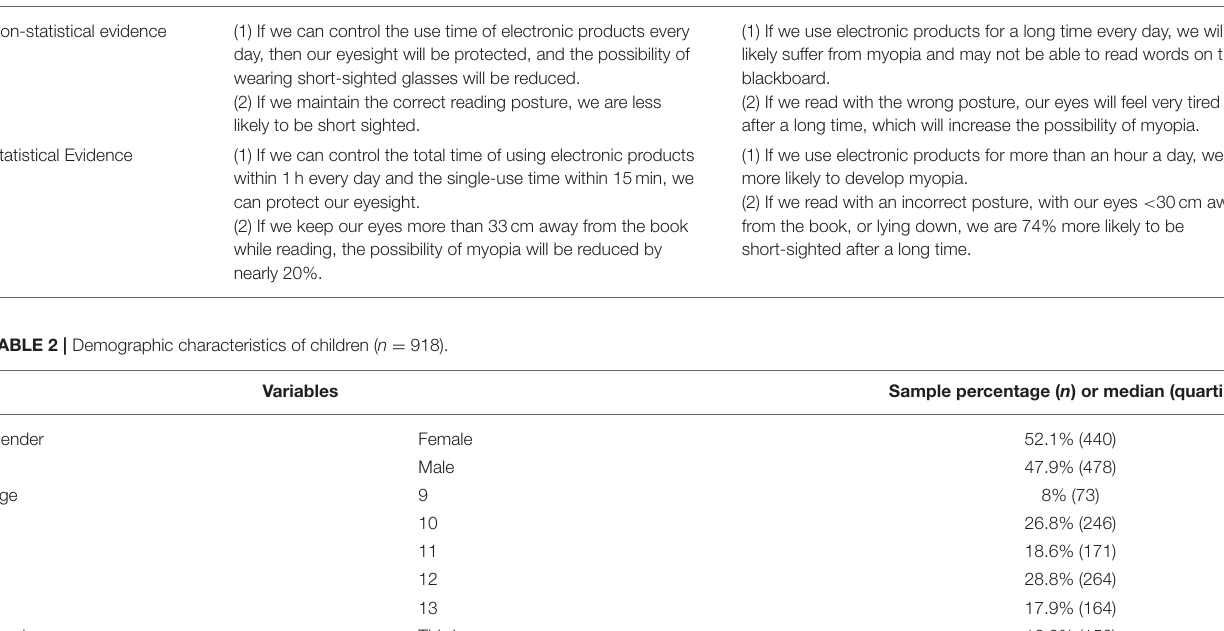
TABLE 1 | Message framing materials used in the study. Gain- framed Loss-framed